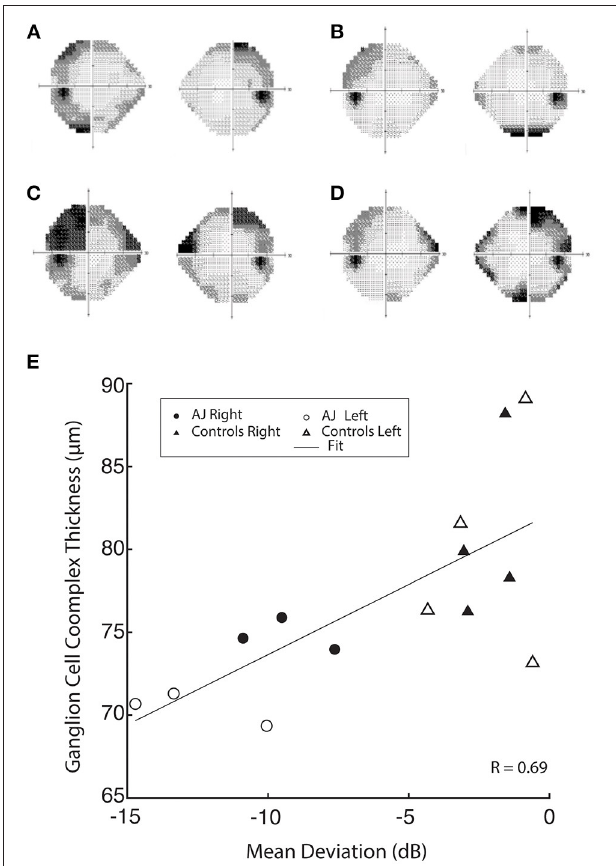
FIGURE 3 | Humphrey 24-2 visual field automated perimetry of AJ prior to discontinuation of cabergoline (AJ0; A ), at the time of study enrollment (AJ1; B ) illustrating a single temporal defect in OD, mean deviation − 6.15 dB, and supratemporal defect in OS, mean deviation − 6.57 dB. Following cabergoline use (AJ2; C ), ophthalmologic evaluation was notable for OD supratemporal and nasal defects (mean deviation − 9.51 dB) and OS temporal-greater-than-nasal defects (mean deviation − 13.35 dB), reflecting worsening of visual function. Further evaluation after final cessation of cabergoline (AJ3; D ), demonstrates subtle worsening of the temporal defect extending infratemporally (mean deviation − 9.65) and significantly improved supratemporal and nasal defects (mean deviation − 6.05), reflective of overall improvement in visual function. (E) demonstrates a positive